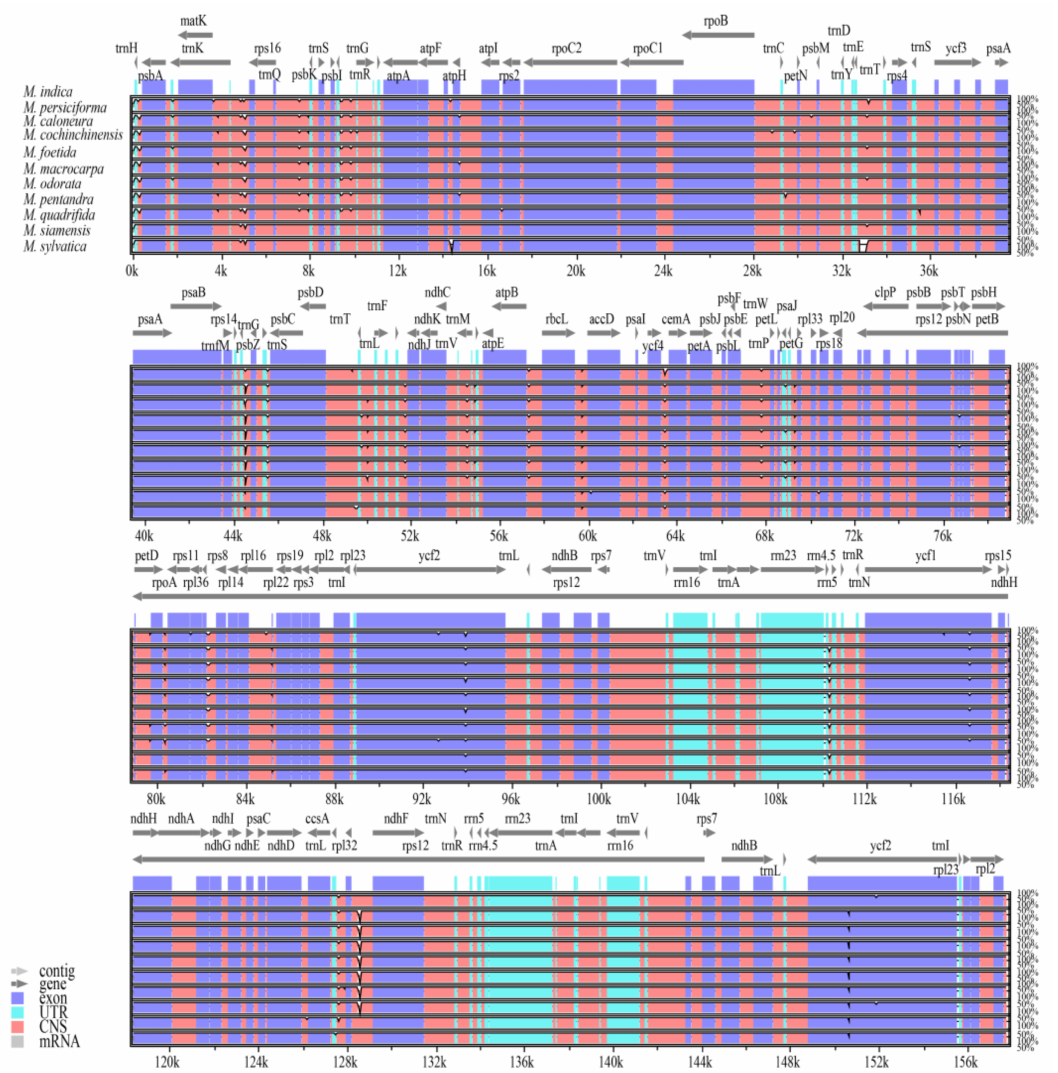
Figure 5. Complete chloroplast genome comparison of the 11 species of Mangifera using the mVISTA alignment program. Coding and noncoding regions are coloured blue and red, respectively. The Y-scale represents the percentage of identity, ranging from 50% to